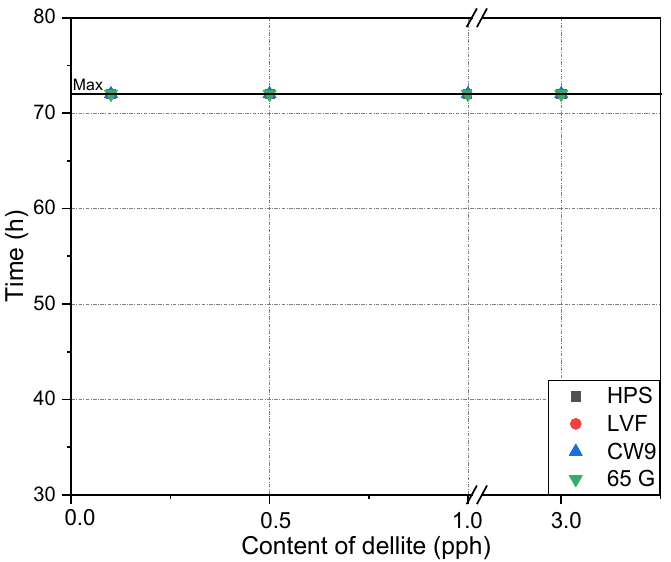
Figure 5. Effect of contents of dellite addition on the cohesion at 20 °C of silicone pressure-sensitive adhesives.